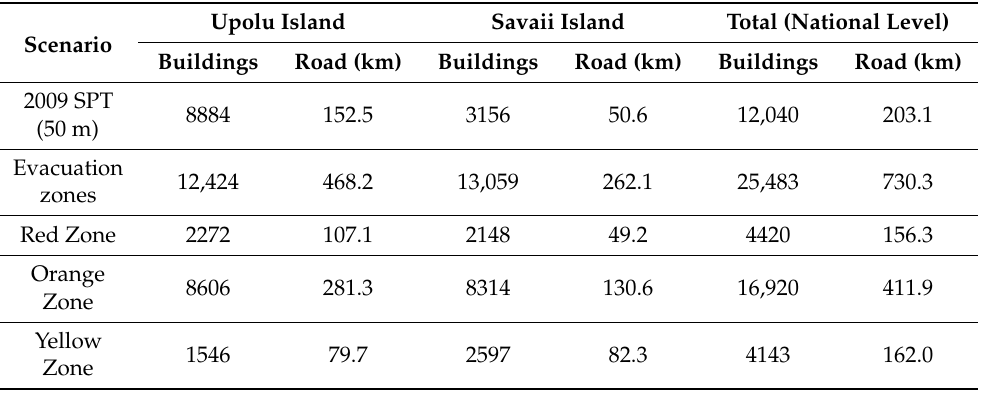
Table 2. Comparison of buildings’ and road exposure between the 2009 tsunami scenario inundation and existing tsunami red, orange, and yellow evacuation zones for the whole country.